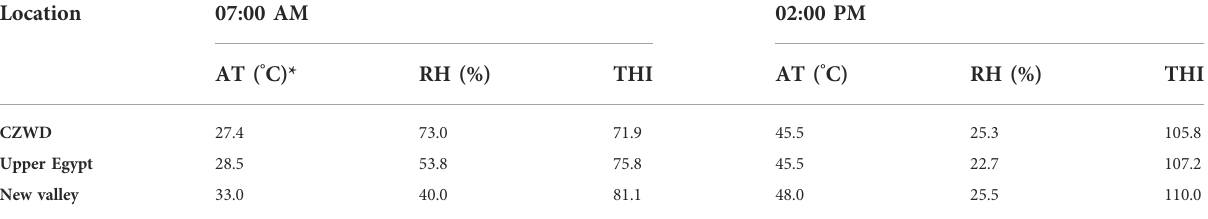
TABLE 1 Climatic parameters in the morning and afternoon for various locations on the day of sample collection.